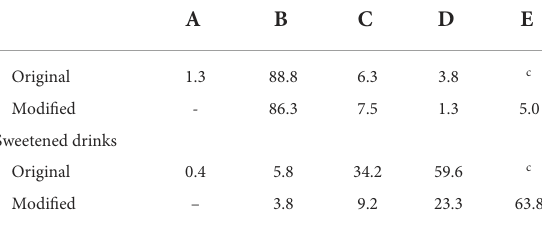
TABLE 2 Shifts in distribution (%) a across scoring categories for food groups for which the algorithm was adapted b for better adherence to dietary guidelines, as described in Julia et al. (21).